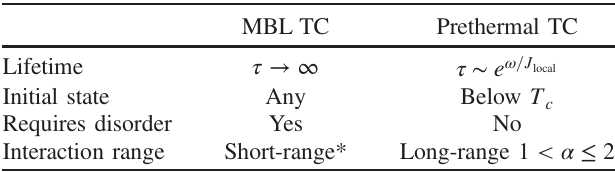
TABLE I. Differences between MBL and prethermal discrete time crystalline order in one-dimensional systems. The star next to “ Short-range ” indicates that the range of the interaction must only be sufficiently short so that MBL is